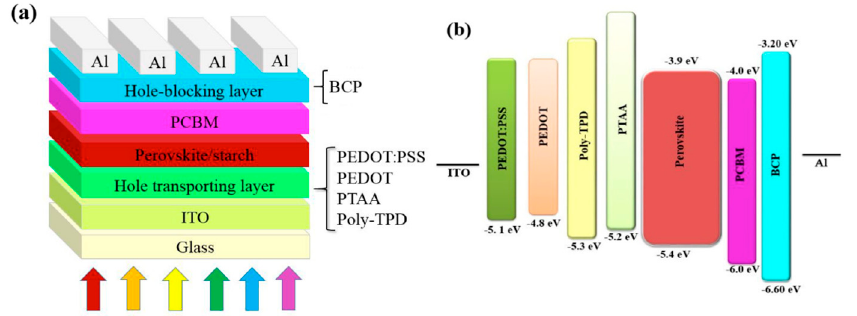
Figure 5. Structure of perovskite solar cells. ( a ) Device architecture and ( b ) energy-band diagram of the devices with PEDOT: PSS, PEDOT, Poly-TPD, and PTAA as the HTLs. The average measured photovoltaic parameters (under simulated one sun AM1.5G irradiation) are summarized in Table 1. Table 1. The average measured photovoltaic parameters for inverted planar perovskite solar cell with